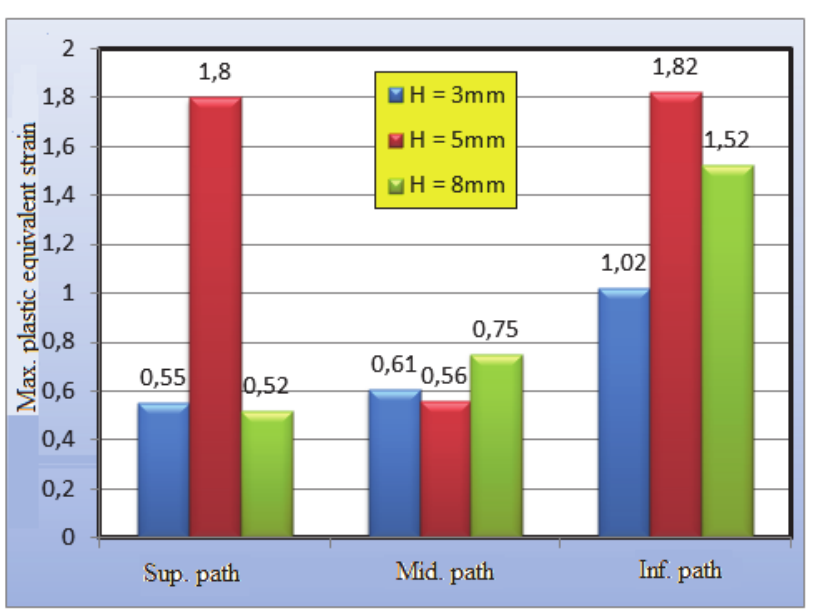
Figure 21: Evolution of maximum equivalent plastic deformations for different depths of the die